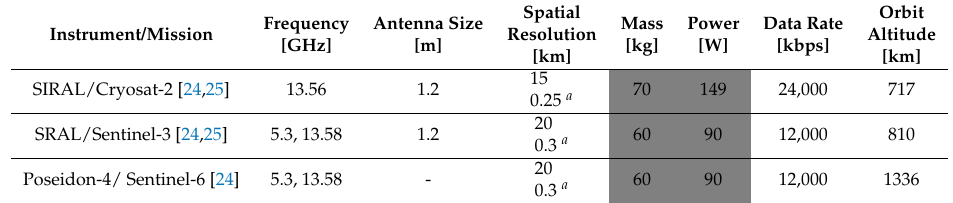
Table A12. Survey of Radar Altimeter instruments with SAR processing.